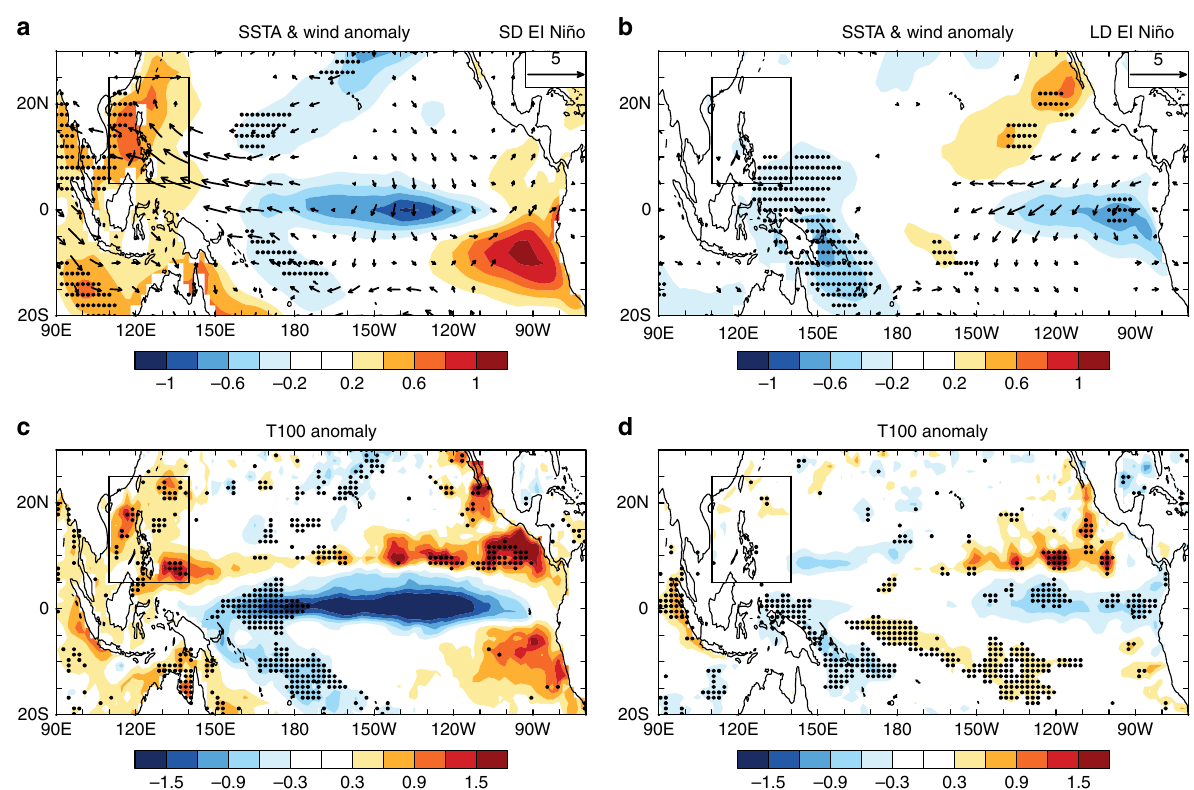
Fig. 3 Low-level wind and upper ocean thermal conditions during the short duration and long duration El Niño events. Composite anomalies of a sea surface temperature (shading, units: K) from ERSST reanalysis dataset and 850-hPa wind (vectors, units: m s – 1 ) from NCEP-NCAR reanalysis dataset, and c mean ocean temperature between 5 and 100 m (units: K) from SODA reanalysis dataset for the short duration El Niño events; b , d as in a , c , but for the long duration El Niño events. The stippled areas indicate the values are statistically signi fi cant at the 95% con fi dence level. Black boxes indicate the South China Sea and the Western Philippine Sea region. Wind anomalies <0.2m s – 1 are not